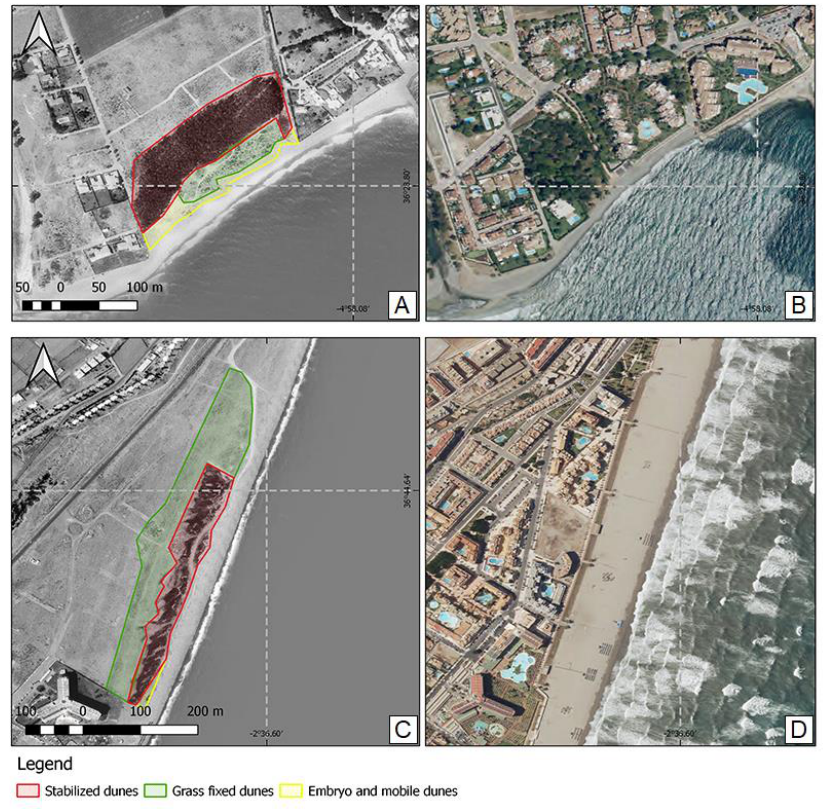
Figure 5. Dune systems urbanized in Málaga and Almería provinces. System no. 14 Playa Nueva Andalucía in 1977 ( A ) and 2016 ( B ), and System no. 36 Playa de Roquetas in 1977 ( C ) and 2016 ( D ).